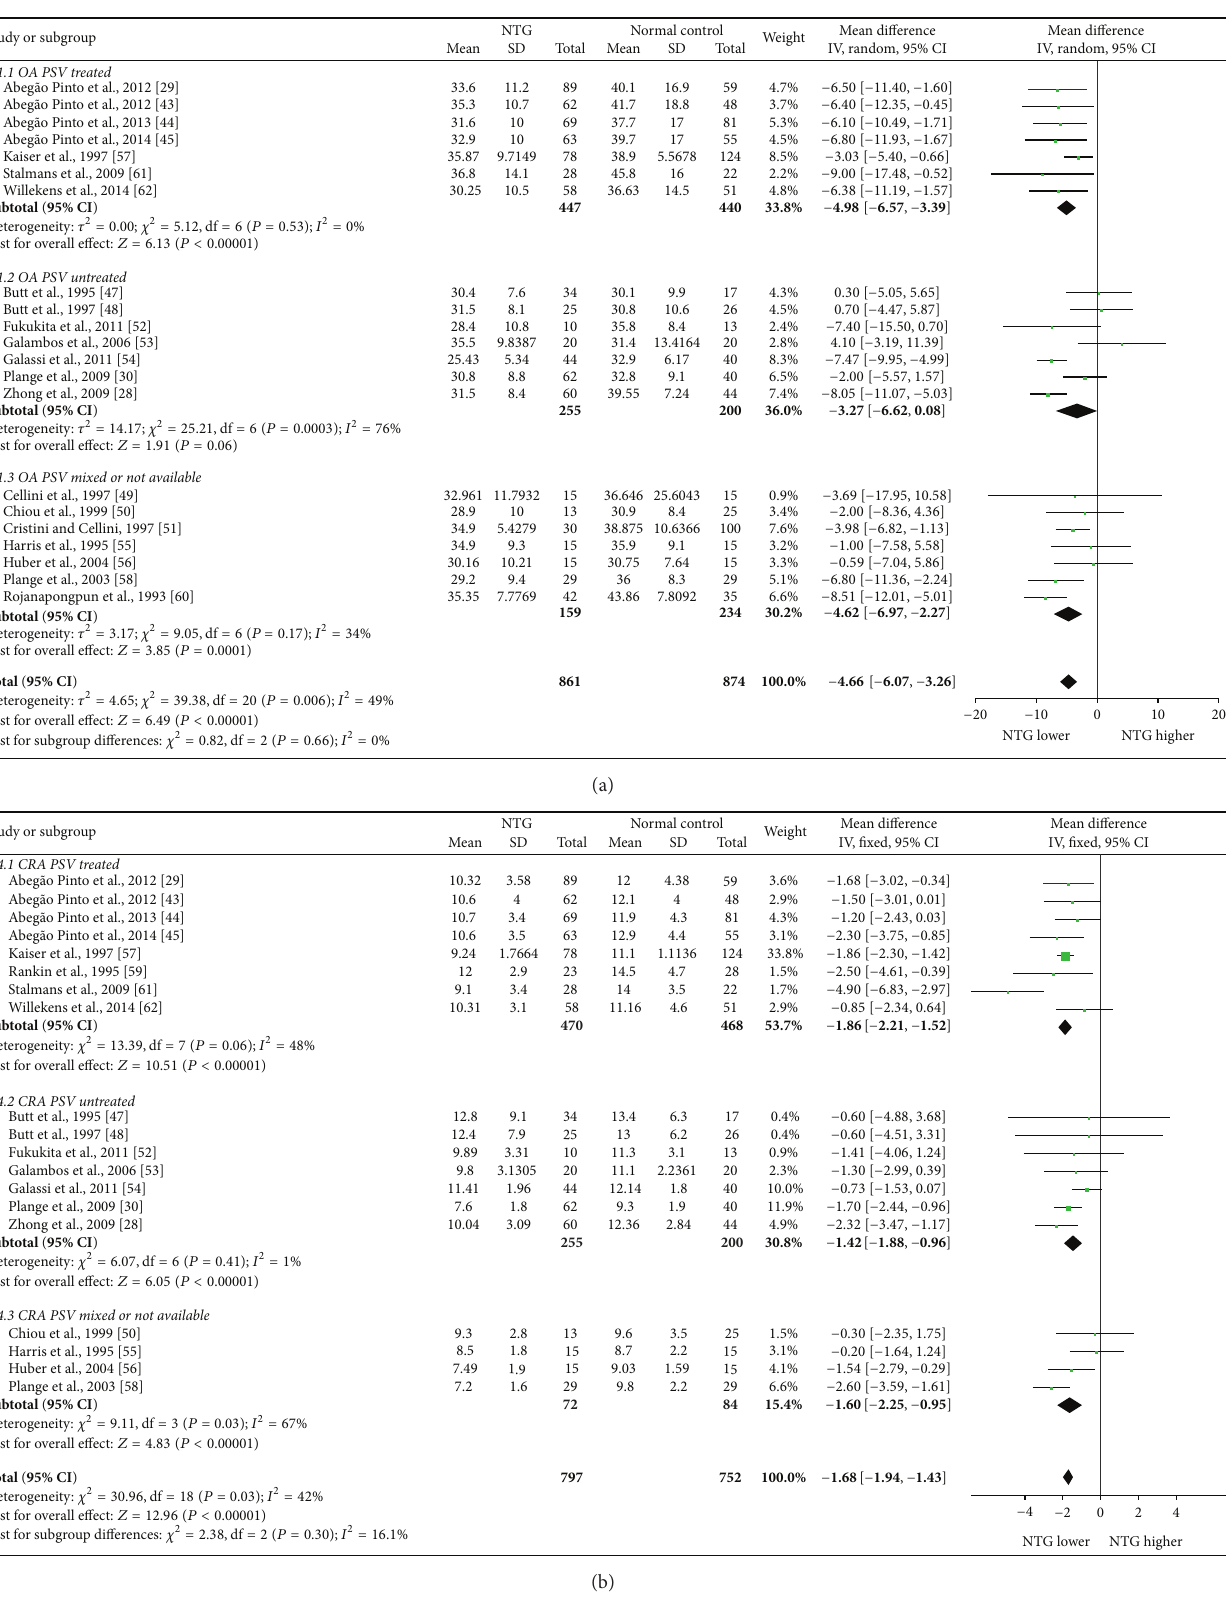
Figure 4: Forest plot of PSV in OA and